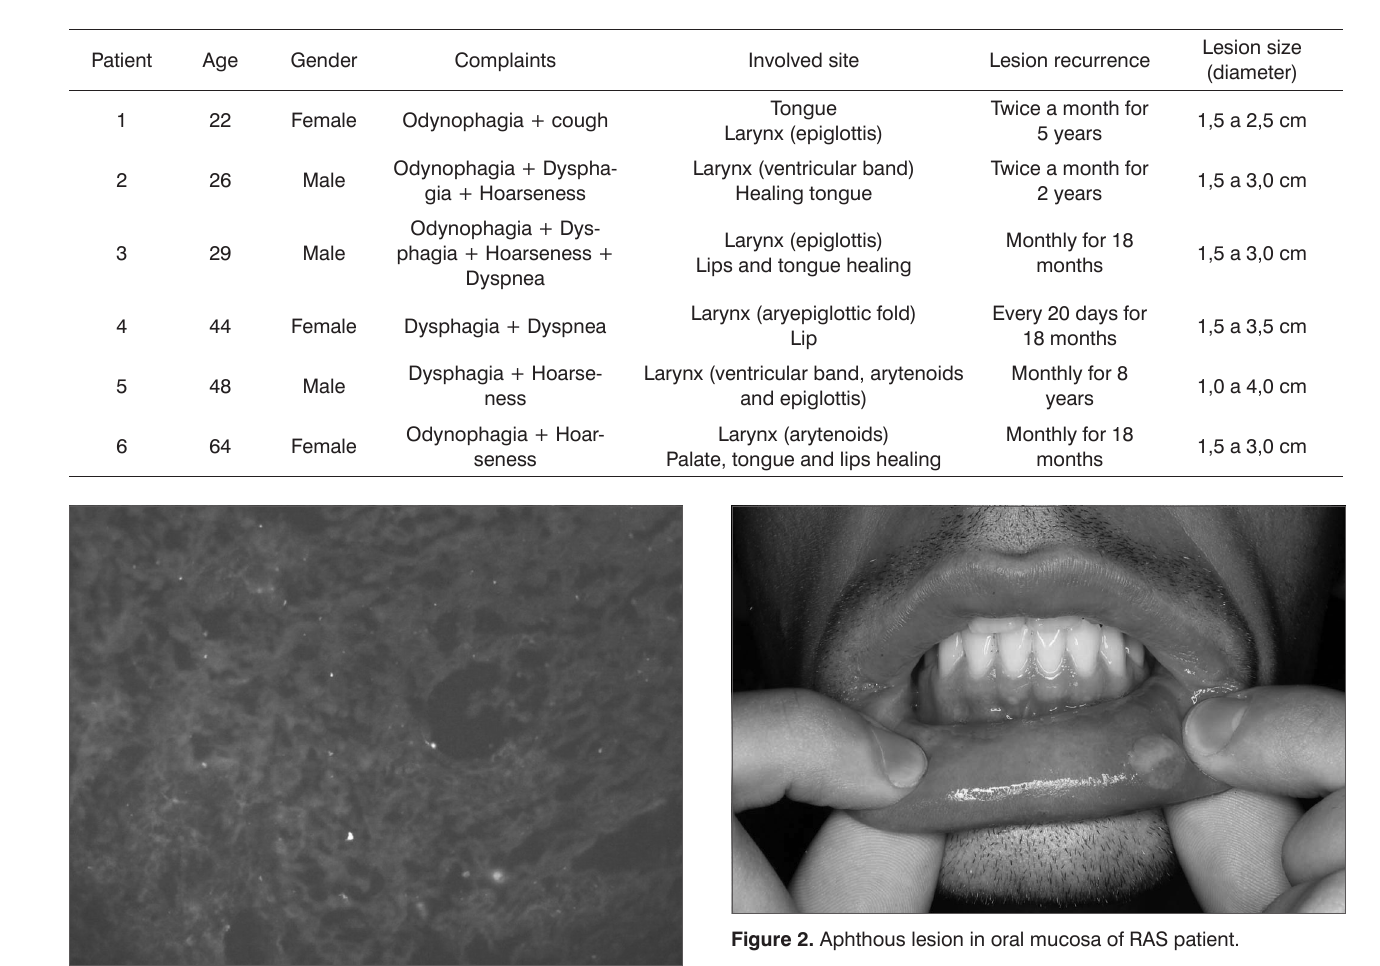
Table 1. Characteristics of patients with atypical RAS